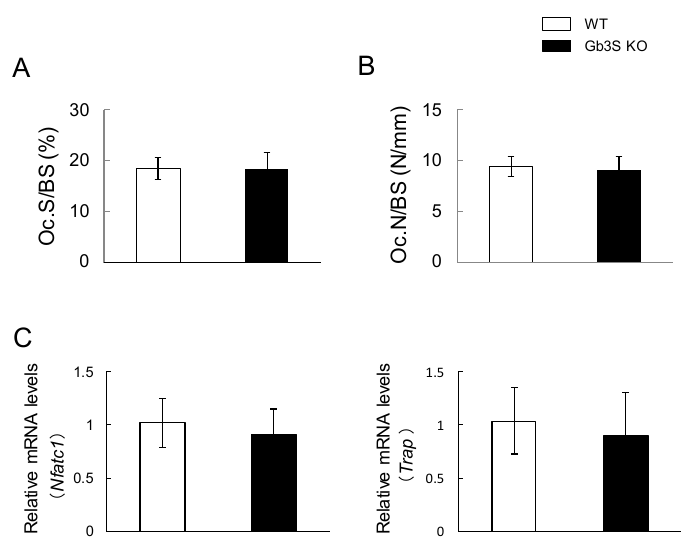
Figure 8. No e ff ects of Gb3 synthase deficiency on bone resorption parameters and gene expression of osteoclast di ff erentiation markers ( Nfatc1 and Trap ). ( A ) Osteoclast surface / bone surface (Oc.S / BS, %) in 15-week-old mice (male, n = 9 for WT, n = 10 for Gb3S KO). ( B ) Osteoclast numbers / bone surface (Oc.N / BS, number / mm) in 15-week-old mice (male, n = 9 for WT, n = 10 for Gb3S KO). ( C ) mRNA expression of Nfatc1 and Trap . RNA isolated from femur and tibia in 15-week-old mice (male, n = 12 for WT, n = 12 for Gb3S KO). Data are expressed as mean ± S.D.